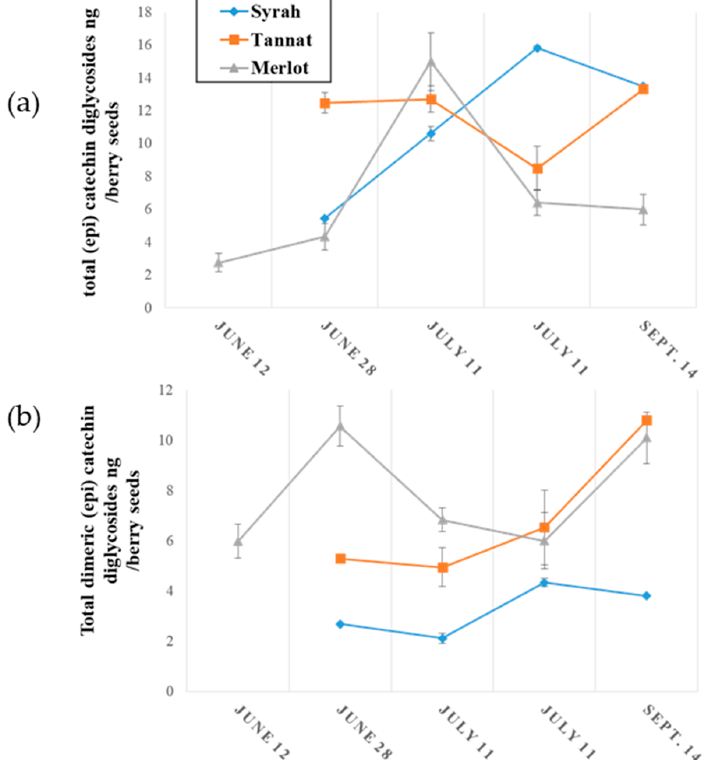
Figure 5. Evolution of ( a ) (epi) catechin diglycosides and ( b ) (epi) catechin dimer diglycosides during grape seeds